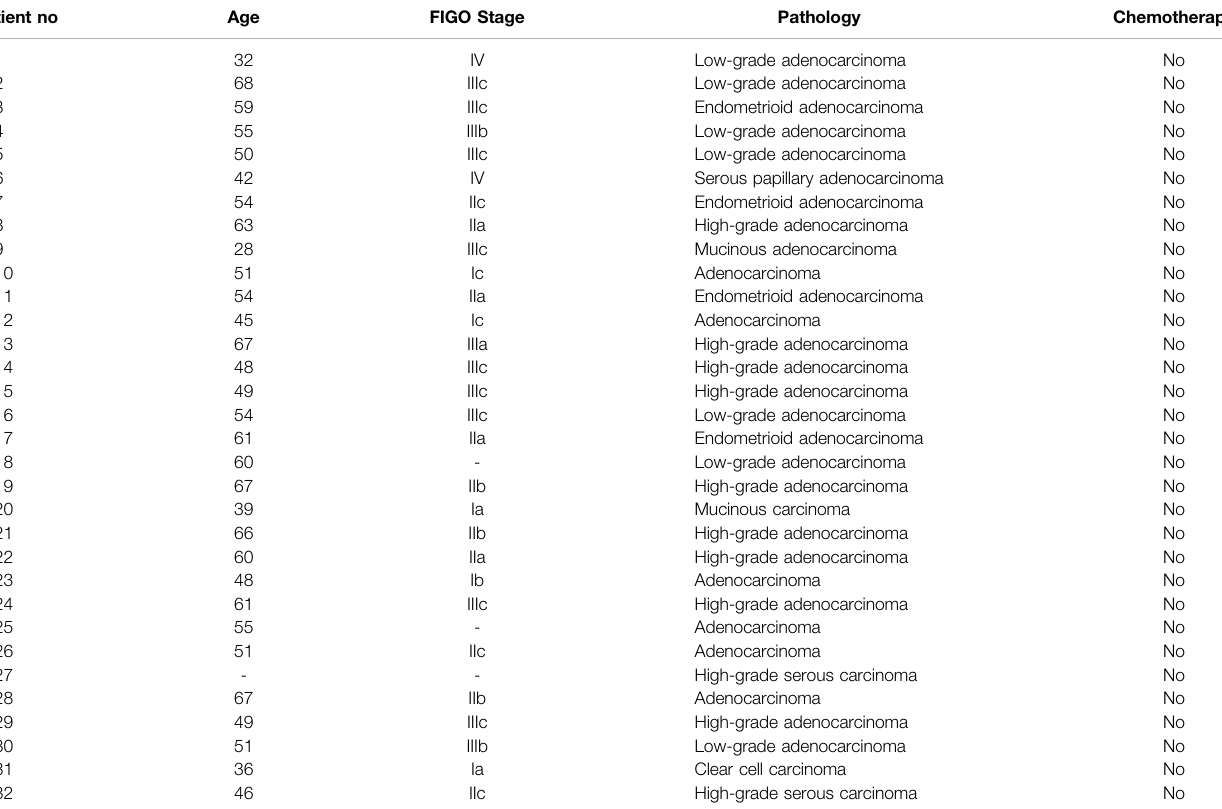
TABLE 1 | Clinical and pathological characteristics of patients with OvCa. Patient no Age FIGO Stage Pathology Chemotherapy